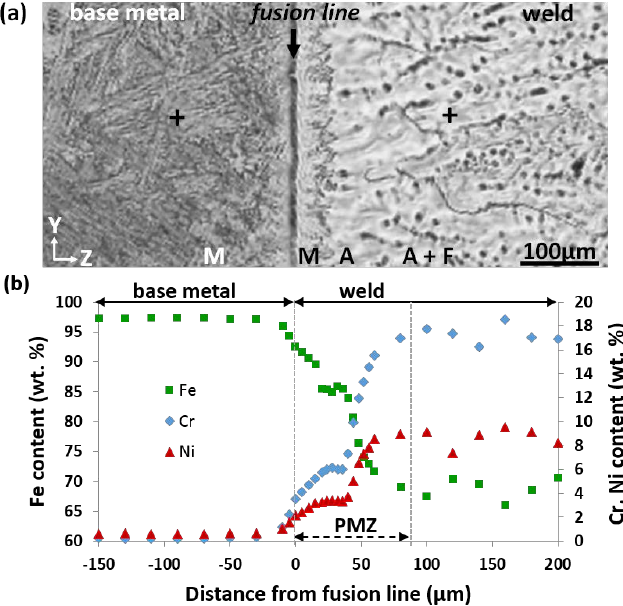
Figure 2. Transverse section of the dissimilar weld. ( a ) Optical micrograph after double etching (M martensite, A austenite, F ferrite); ( b ) Composition profiles (Fe, Cr, Ni) measured by WDS along the line marked with crosses on the above micrograph: the transition zone is noticed as PMZ (partially mixed